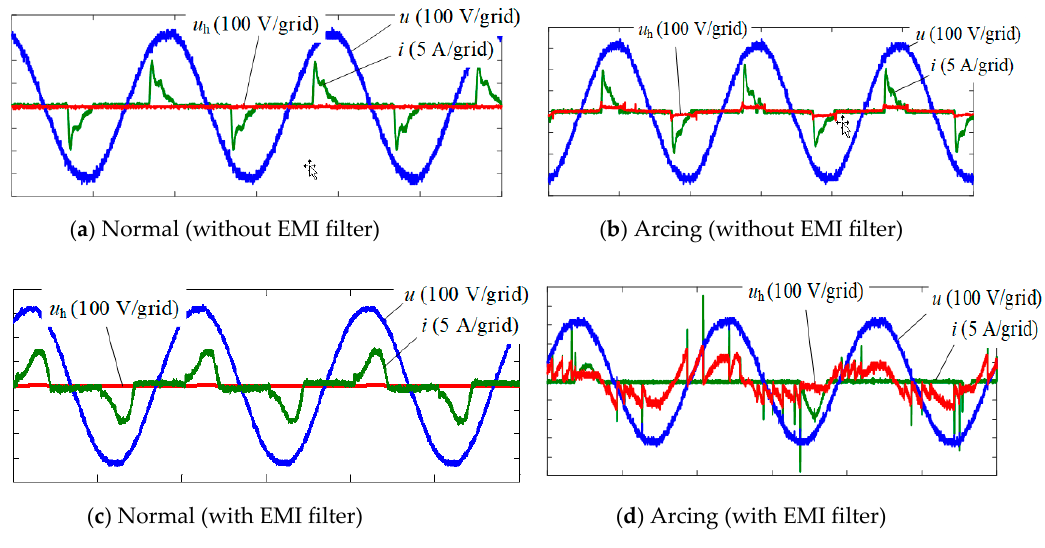
Figure 7. Diode rectifier with capacitive filter.